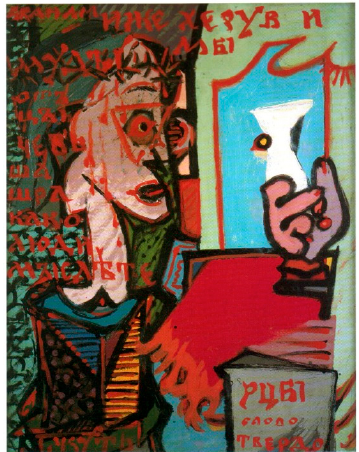
Figure 8. John Graham, Untitled (Artist Sweating Blood) , ca. 1942–1943, oil on canvas, 29 3/4 × 23 1/2 John Graham, Untitled (Artist Sweating Blood) , ca. 1942–1943, oil on canvas, in. (75.56 × 59.69 cm). Present location unknown. 29 3/4 × 23 1/2 in. (75.56 × 59.69 cm). Present location